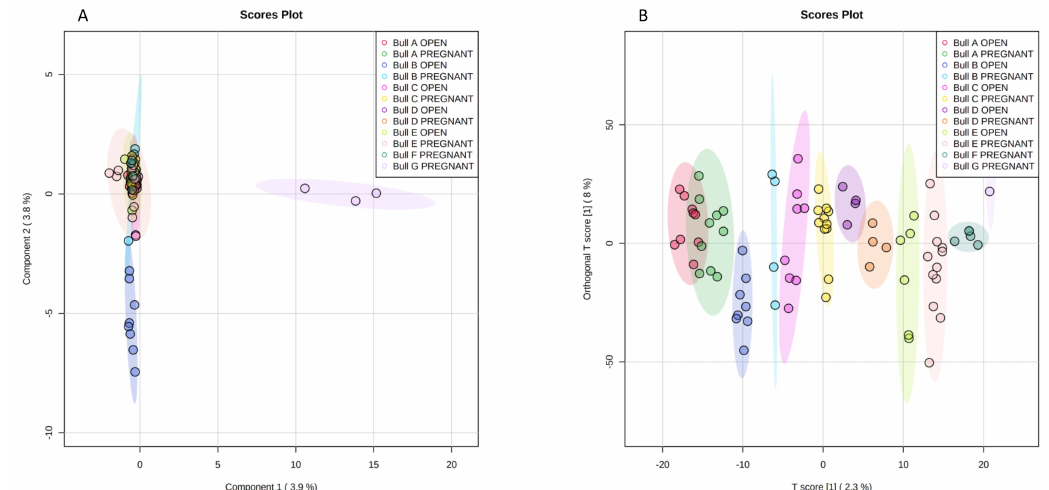
Figure 4. Separation of pregnant and non-pregnant samples from 7 different bulls as a function of pregnancy on Day-62, by sPLS-DA ( A ) and by OPLS-DA ( B ) (Q2: p < 0.01, R2Y: p < 0.01; 2 samples of Bull G-pregnant hidden down the legend). Empirical p -values were obtained after 100